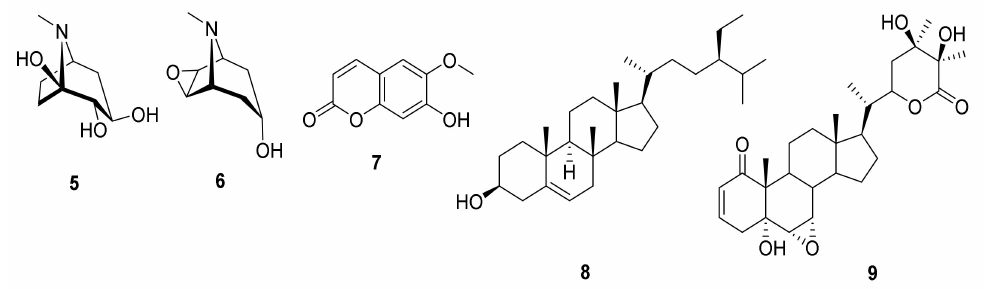
Figure 1. Phytochemicals isolated previously from M. autumnalis